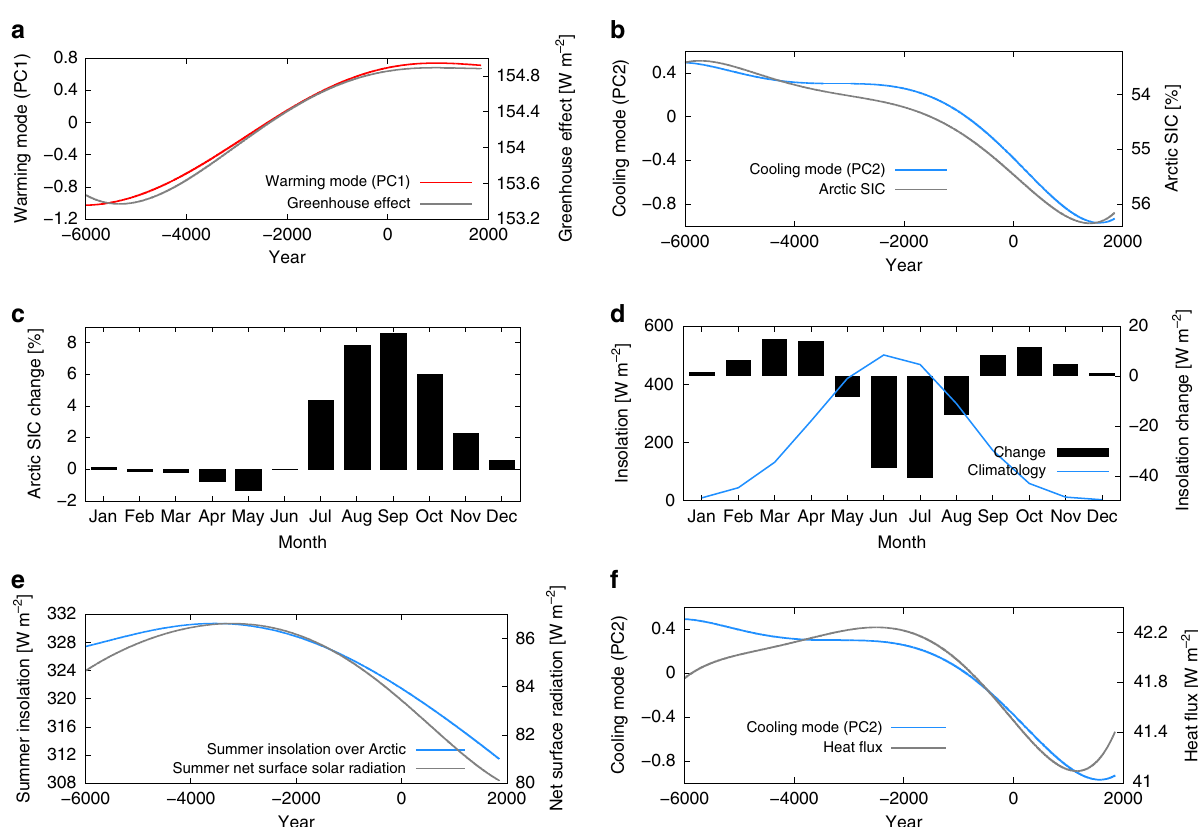
Fig. 4 Time evolution of the warming mode is correlated with the greenhouse effect while the cooling mode is associated with the Arctic sea-ice increase. a The gray curve shows the low-pass fi ltered greenhouse effect and the red curve the low-pass fi ltered warming mode (PC1). The greenhouse- gas effect is de fi ned as the difference between the upward surface thermal radiation and the outgoing longwave radiation at the top of the atmosphere [W m − 2 ]. b Low-pass fi ltered normalized cooling-mode (PC2) and low-pass fi ltered annual Arctic sea-ice concentration (SIC) in %. Please note that the right y -axis is fl ipped. c Change in the seasonal cycle of the Arctic SIC between the fi rst and last one hundred years of the simulation. d Blue curve shows the simulated climatological insolation. Bars indicate the change in the seasonal cycle of the insolation between the fi rst and last one hundred years of the simulation. e Low-pass fi ltered summer (JAS) insolation (blue curve) and summer (JAS) net surface solar radiation (black curve). f The gray curve shows the area-averaged heat fl ux from the ocean to the atmosphere in W m − 2 and the blue curve the cooling mode (PC2). Except for the warming mode (PC1), the cooling mode (PC2) and the greenhouse effect all data is area-averaged from 60 ∘